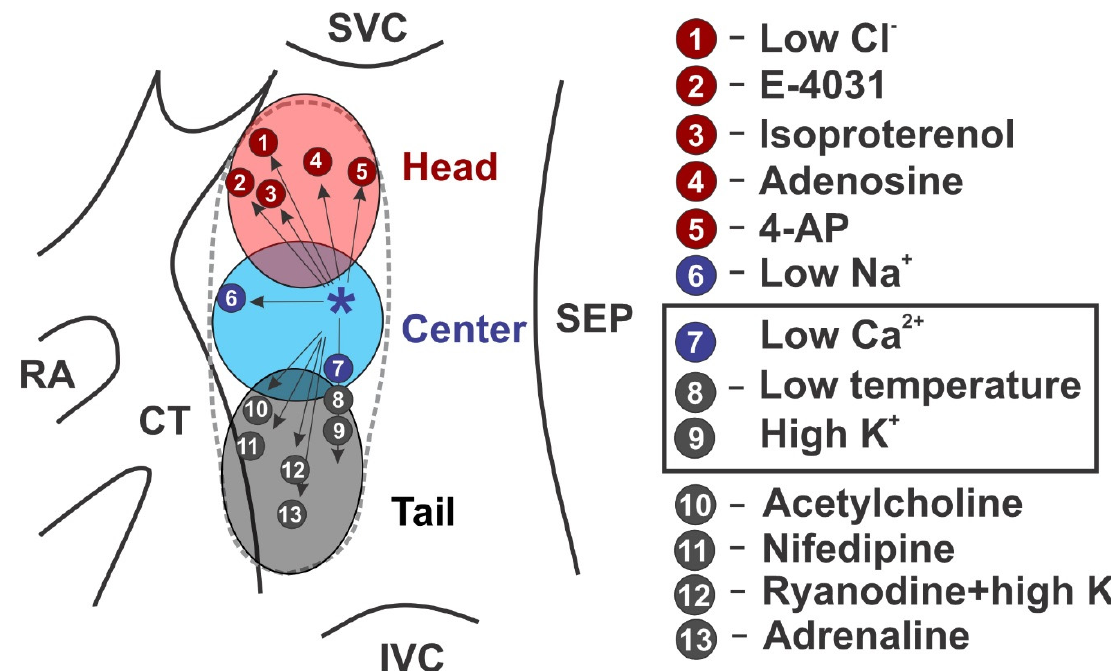
Figure 3. Summary of the pacemaker shifts among multiple SAN clusters. Figure is modified based on the data from Boyett et al. [5] with adding data from Lang et al. (point 3) [7], Li et al. (point 4) [4] and Shinohara et al. (point 13) [43]. All points are from rabbit SAN experiments except otherwise indicated. Diagram summarizes pacemaker shift into different clusters under the following conditions. *—pacemaker at baseline condition. Shift to the superior pacemaker cluster: 1—low Cl - concentration; 2—treatment with E-4031 (class III antiarrhythmic drug that blocks hERG K + channels); 3—isoproterenol (non-selective β -adrenergic agonist); 4—adenosine (human data), and 5—4-aminopyridine (4-AP, selective blocker of I to current). Shift within the center pacemaker cluster: 6—low Na + concentration; 7—low Ca 2+ concentration, low temperature, or high K + concentration. Shift to the inferior pacemaker cluster: 8,9—same condition as for 7, but to different extend. Shift to the inferior pacemaker cluster: 10—acetylcholine (ACh, muscarinic receptor agonist); 11—nifedipine (Ca 2+ channel blocker); 12—ryanodine with high extracellular K + concentration (canine data); and 13—adrenaline ( α - and β -adrenergic receptor